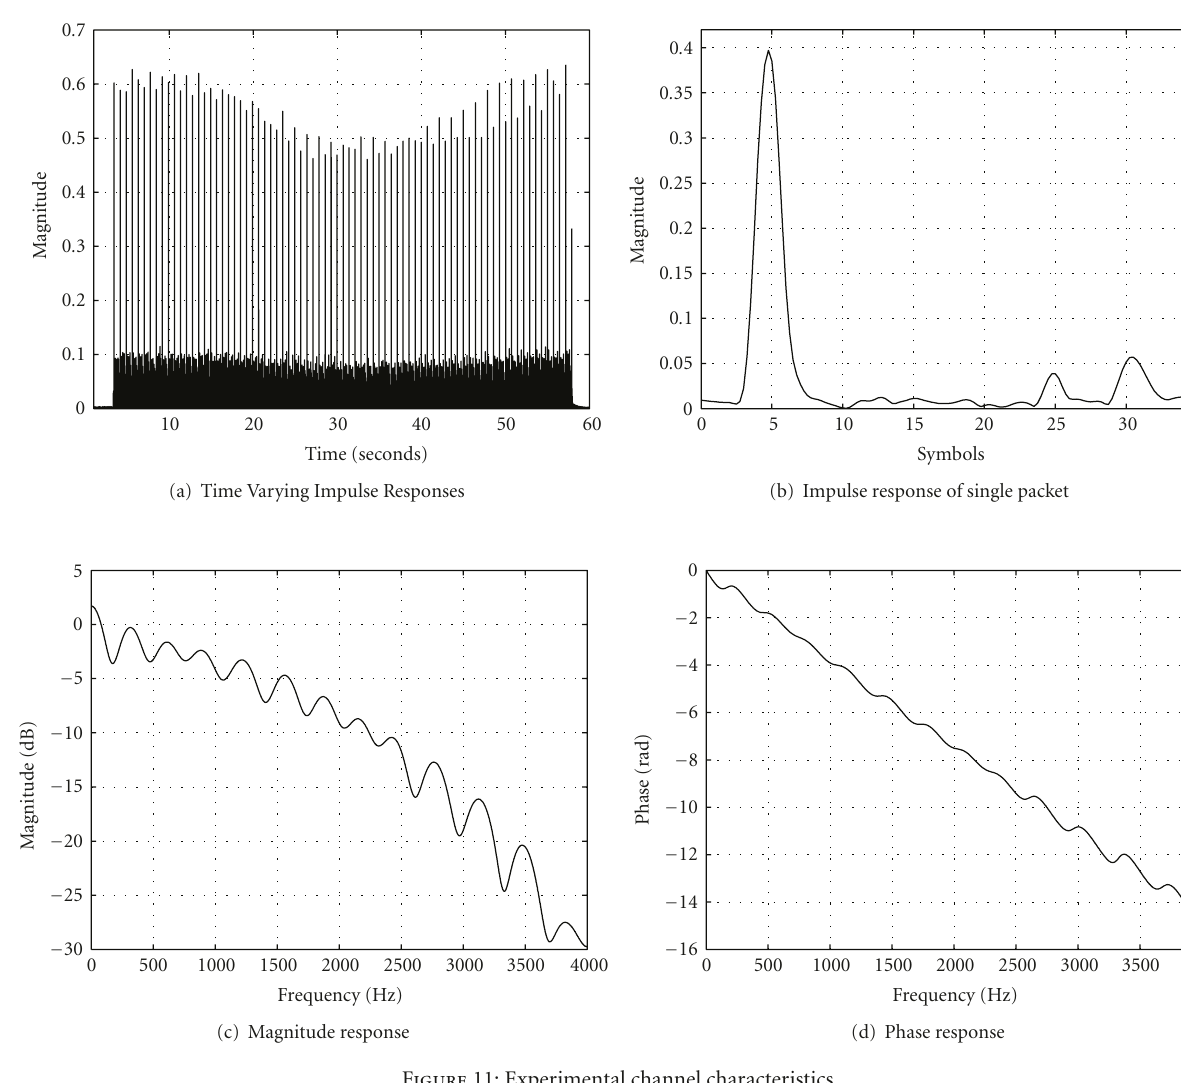
Figure 11: Experimental channel